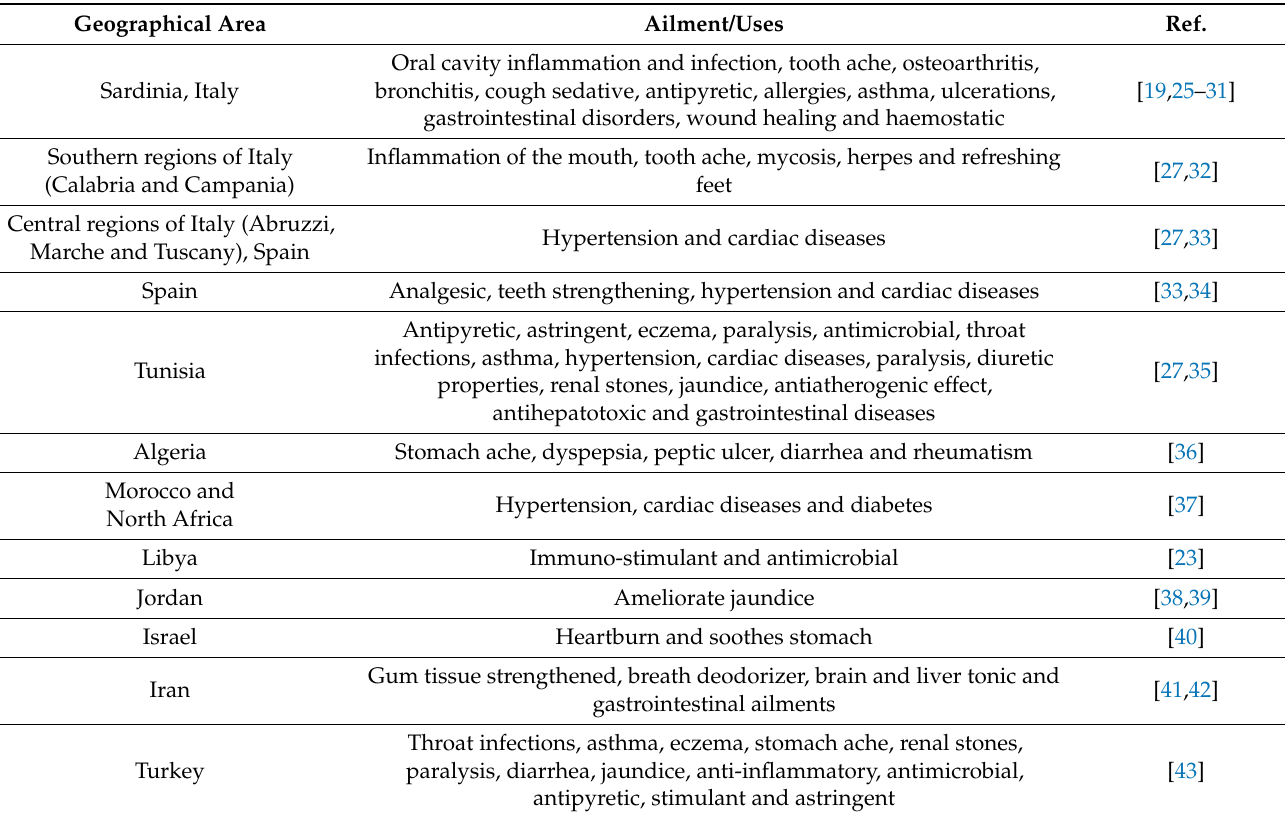
Table 2. Ethnopharmacological uses of Pistacia lentiscus L